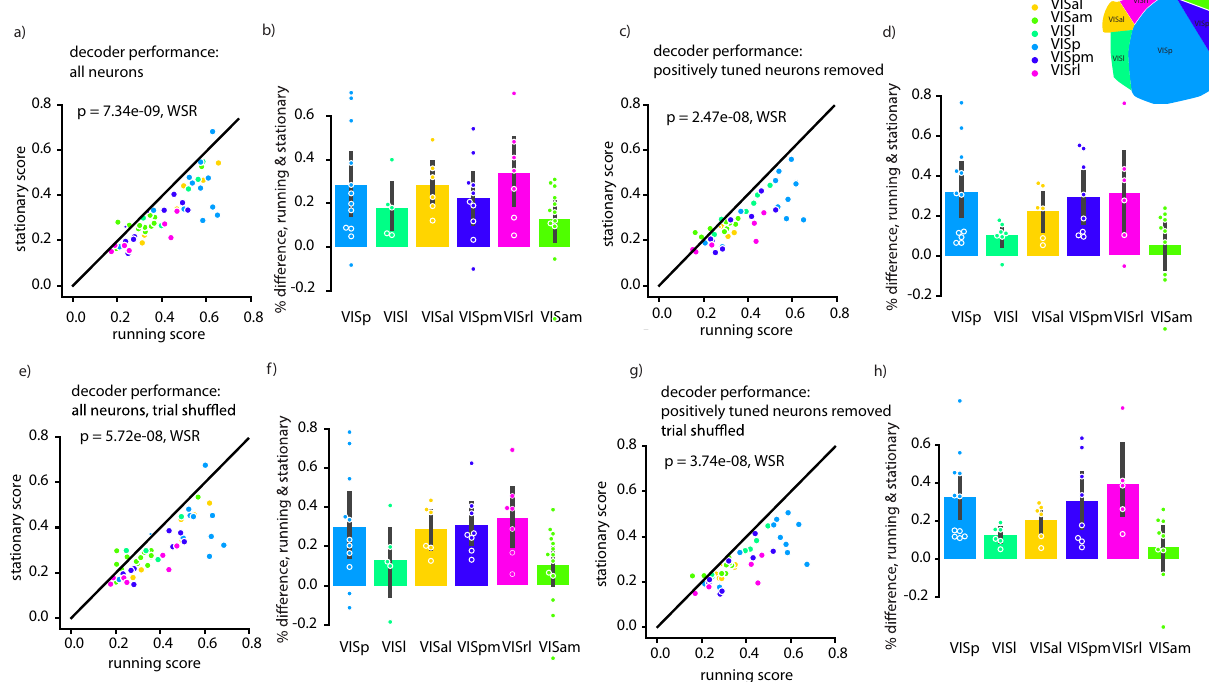
Fig. 2 Decoding performance (multinomial logistic regression) is improved during running relative to stationary periods, independent of net neural tuning or noise correlations. a Average fraction of correctly classi fi ed visual stimuli during running and stationary periods (average over ten 50:50 train/ test splits). Each data point is an individual experiment. Colors indicate brain region recorded. b Data from ( a ) displayed separated into visual regions in dataset, only including experiments in which the difference between running and stationary periods was signi fi cant (in either direction). Each dot is an individual experiment. c , d Same as ( a ), ( b ) but excluding neurons that increase their activity during running. e , f Same as a. but trial-shuf fl ed to remove noise correlations. g , h Same as a. but excluding neurons that increase their activity during running and trial-shuf fl ed to remove noise correlations. Different decoders, all layers, and differential effect of pupil diameter and running speed are presented in Supplemental Figs. 4 – 7. Cell and dataset numbers for each region and condition can be found in Supplementary Table 1. All error bars are 95% con fi dence intervals of mean estimate calculated via 1000 bootstraps. Statistics are calculated via Wilcoxon Sign Rank test, two tailed. Source data are provided as a Source Data fi